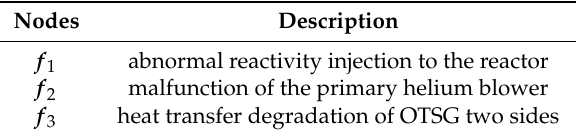
Table 2. Fault nodes to be detected or discriminated.